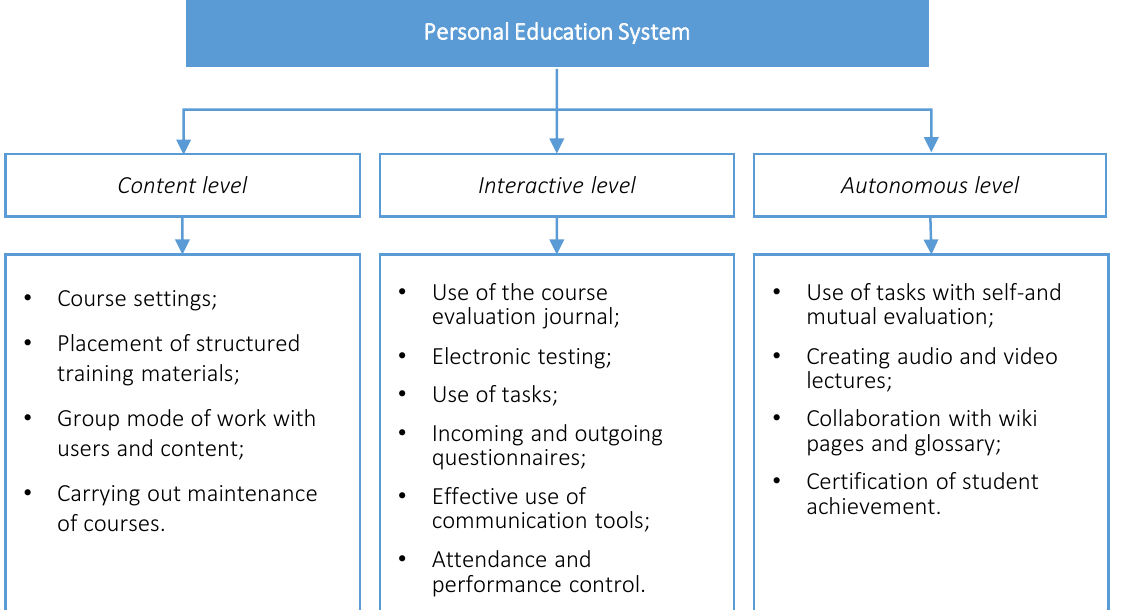
Figure 10. Three-level model of personal educational system in S.Kuznets